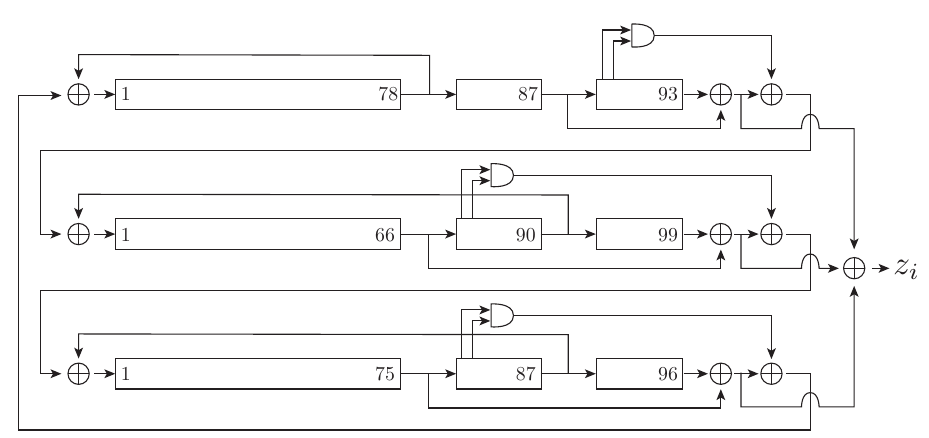
Figure 11: Update function of Trivium - LE ( F